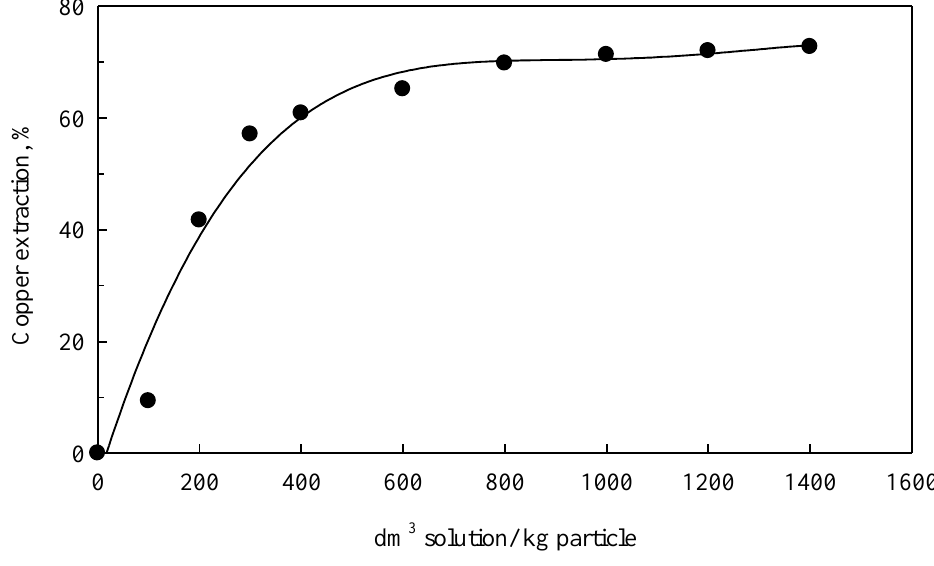
Figure 11. E ff ect of liquid / solid ratio on copper extraction. Working conditions: pH = 10.5, [NH 4 OH] = Figure 11. Effect of liquid/solid ratio on copper extraction. Working conditions: pH = 10.5, [NH 4 OH] 0.7 mol / dm 3 , T = 298 K, PS = 64 µ m, Agitation = 500 = 0.7 mol/dm 3 , T = 298 K, PS = 64  m, Agitation = 500 rpm.